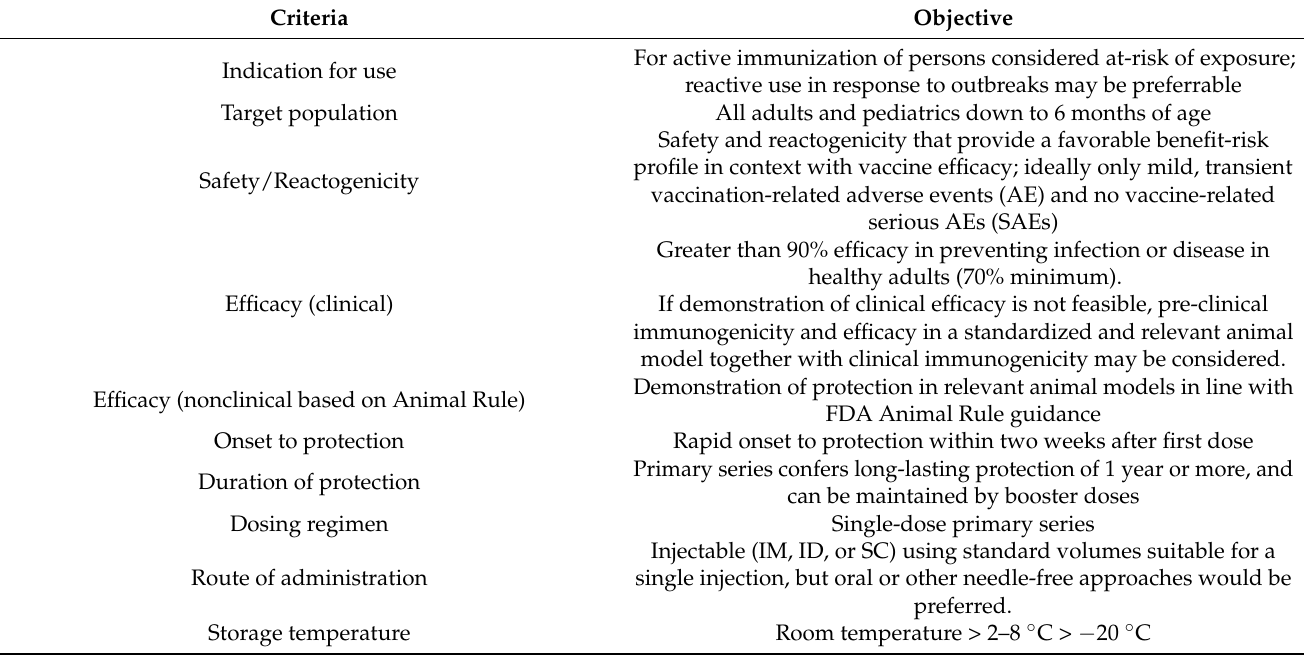
Table 2. Target product profile